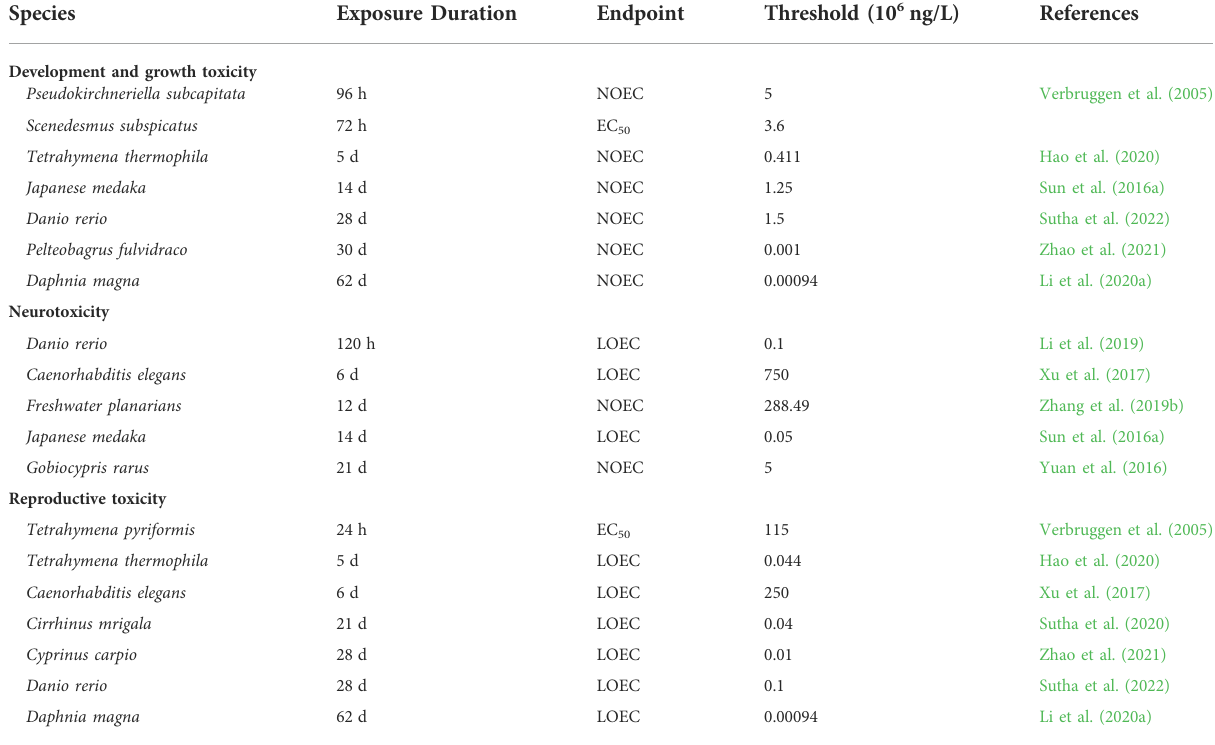
TABLE 2 Date of different toxicity effect endpoints of TCEP in several freshwater